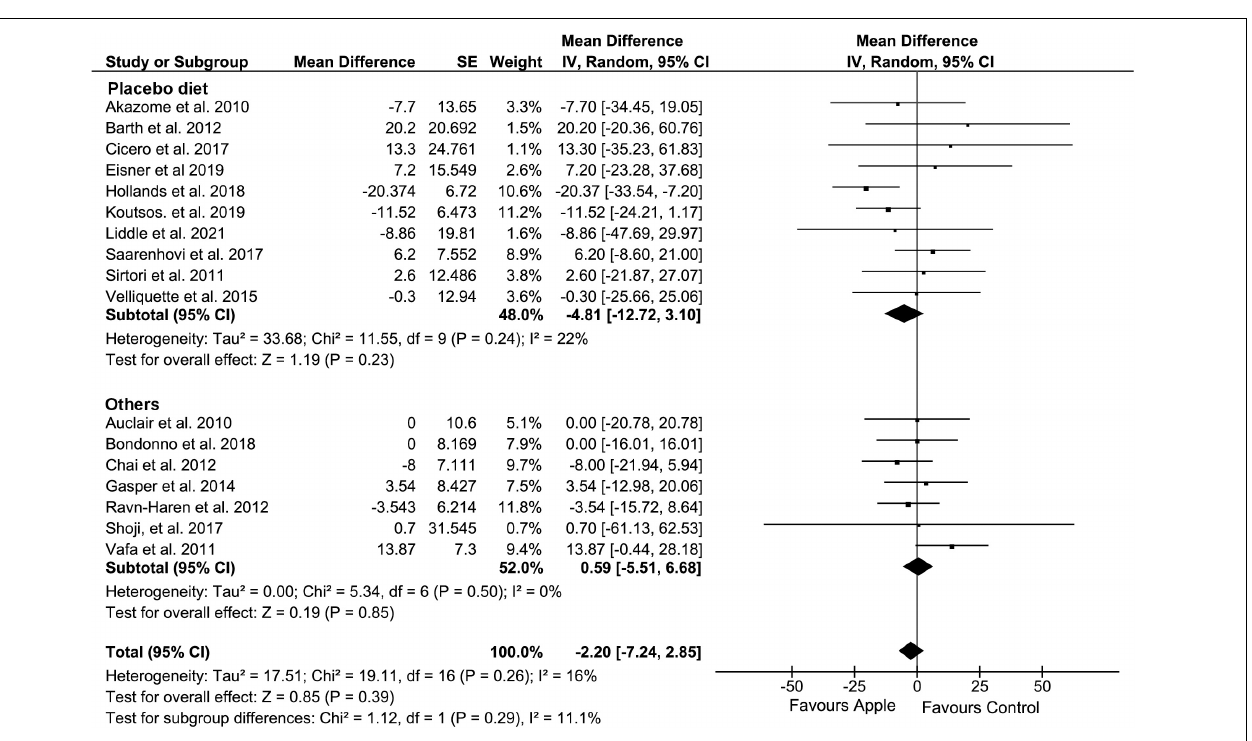
FIGURE 5 | Meta-analysis results of triglycerides. Forest plot is stratified by placebo diet or other alternative diets.